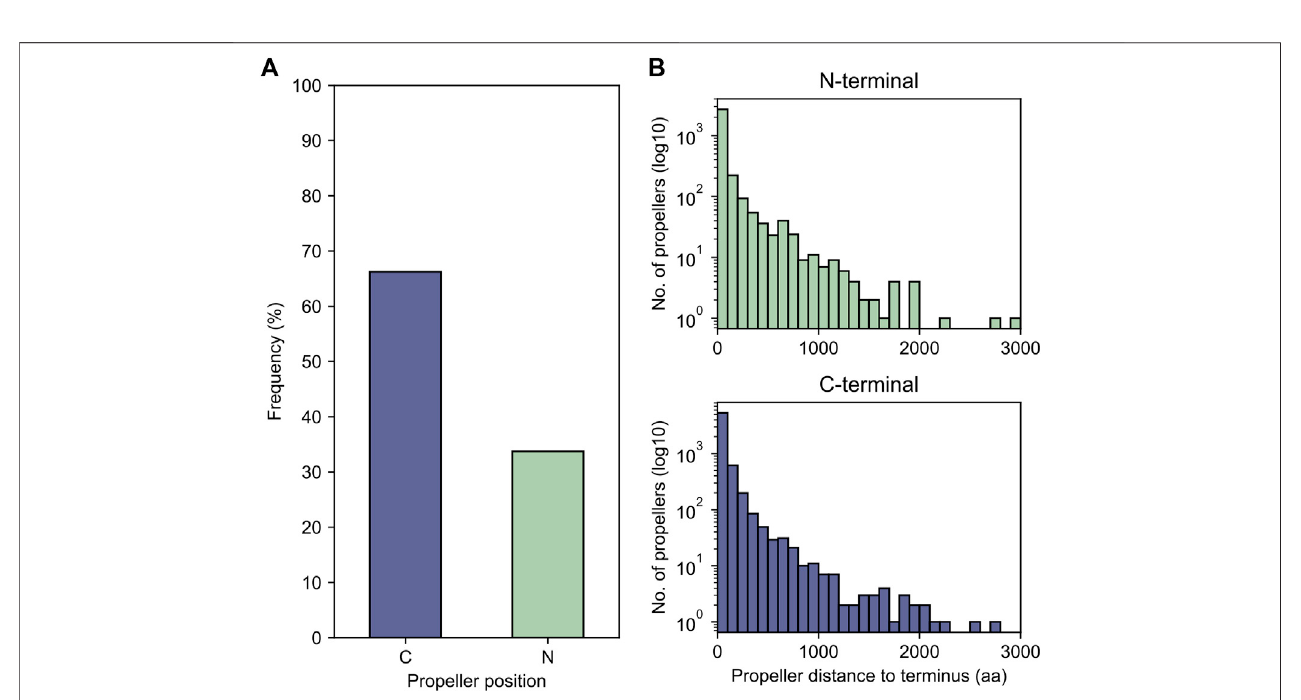
FIGURE8| Theproximityofgloballyhighlyrepetitive β -propellerstothetermini. (A) Theproportionof β -propellersinthedatasetlocalisedclosetooneofthetermini ofthecorrespondinghostprotein.Foreachgloballyrepetitive β -propellerinthedataset,thedistancetoboththeN-andC-terminiwascomputedandtheclosestchosen as the closest to the β -propeller position. (B) Histogram of the number of amino acids separating the β -propeller from its closest terminus.